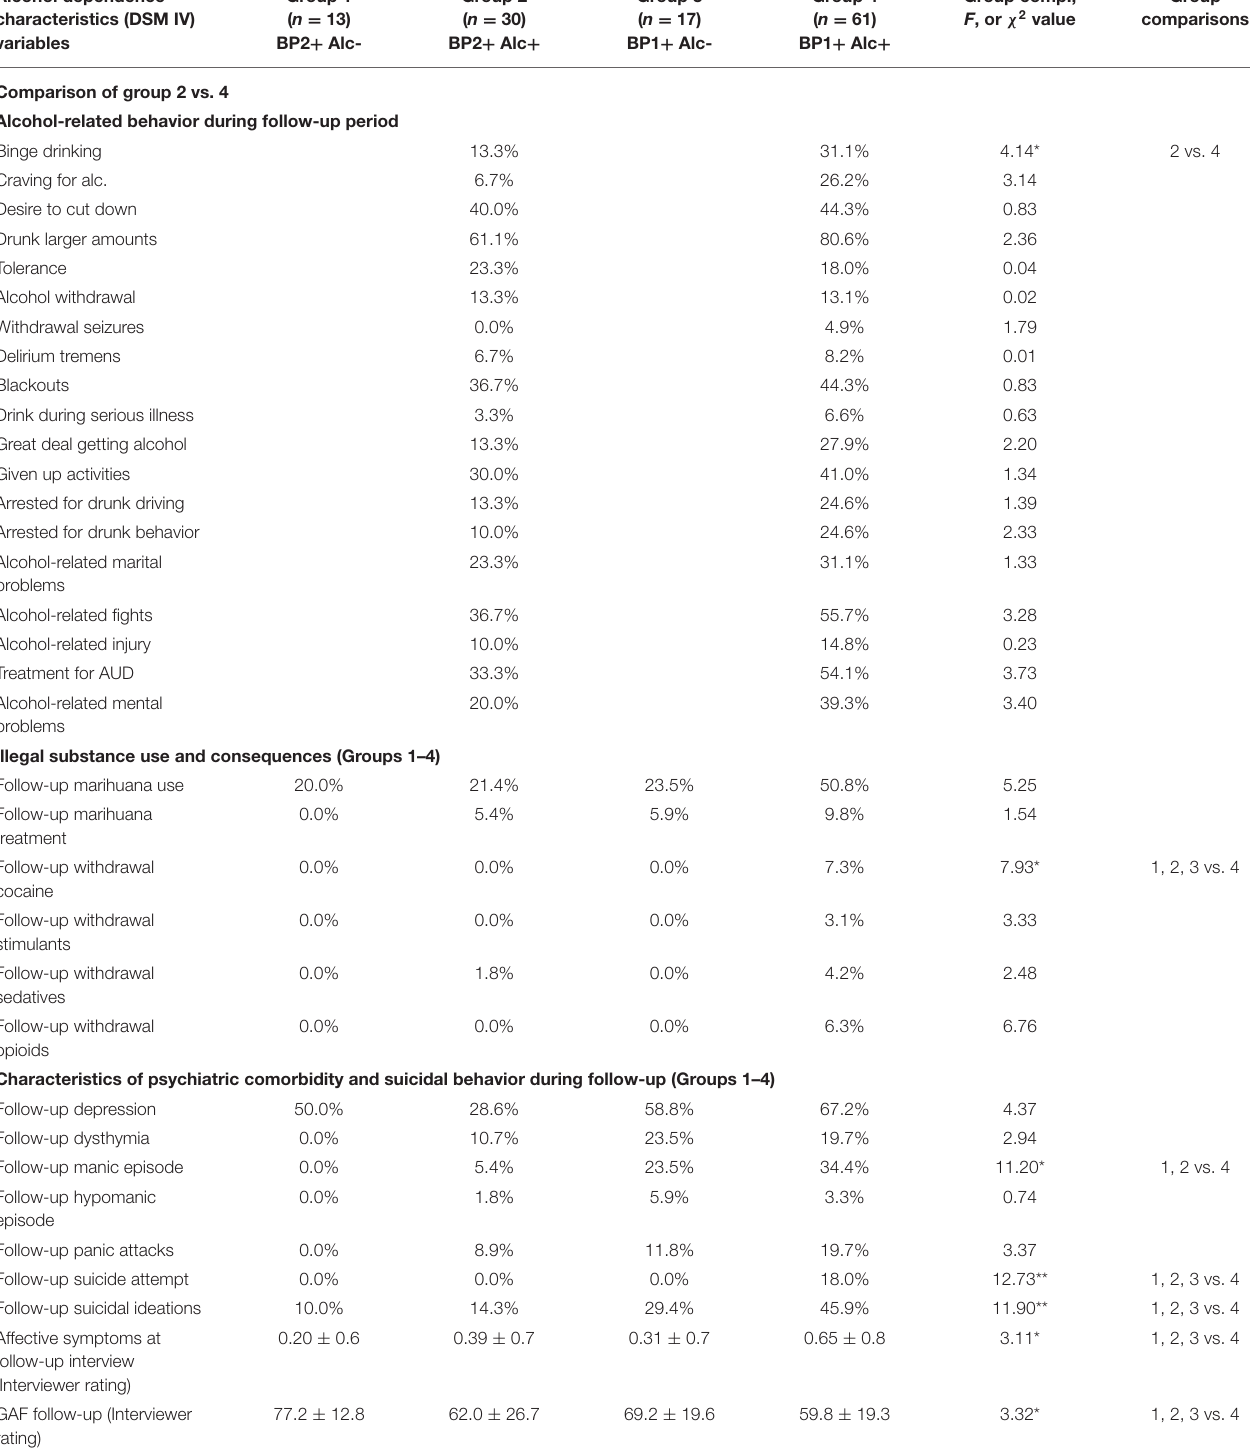
TABLE 4 | Characteristics of Alcohol and Substance Dependence during 5 year Follow-Up in Bipolar 1 and 2 Subjects Divided by Alcohol Dependence Diagnosis. Alcohol dependence characteristics (DSM